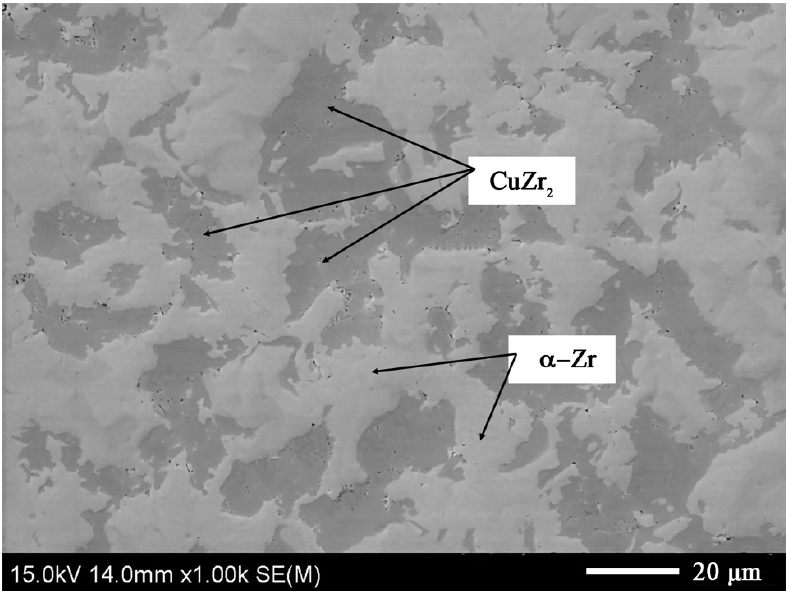
Figure 6. The Zr-10Cu microstructure of the material obtained by the extrusion method: SEM microstructure. Black areas indicate porosity.